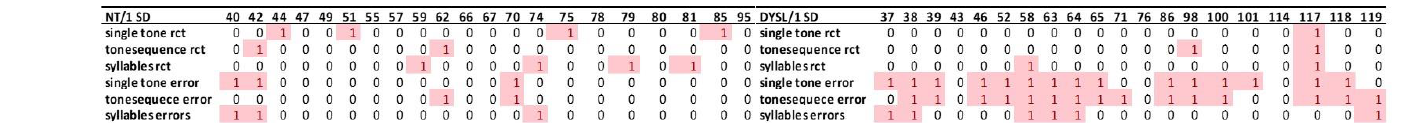
Figure 8. Deviating individual performance/auditory/subtest level. NT: neurotypical normal read- ing children, DYSL: children with dyslexia (numbers in the head row depict the individual subject), rct: reaction time, err: errors, TS: tone sequence ISI: interstimulus interval.